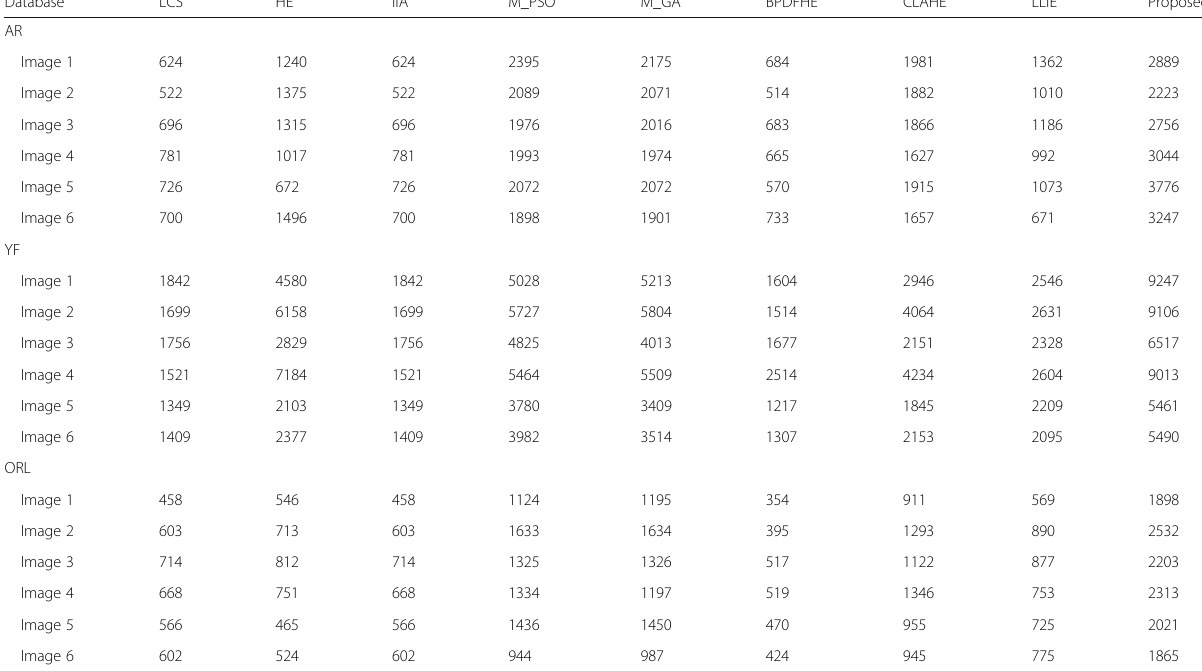
Table 5 Number of edge value comparison between results obtained using different enhancement methods on standard benchmark face